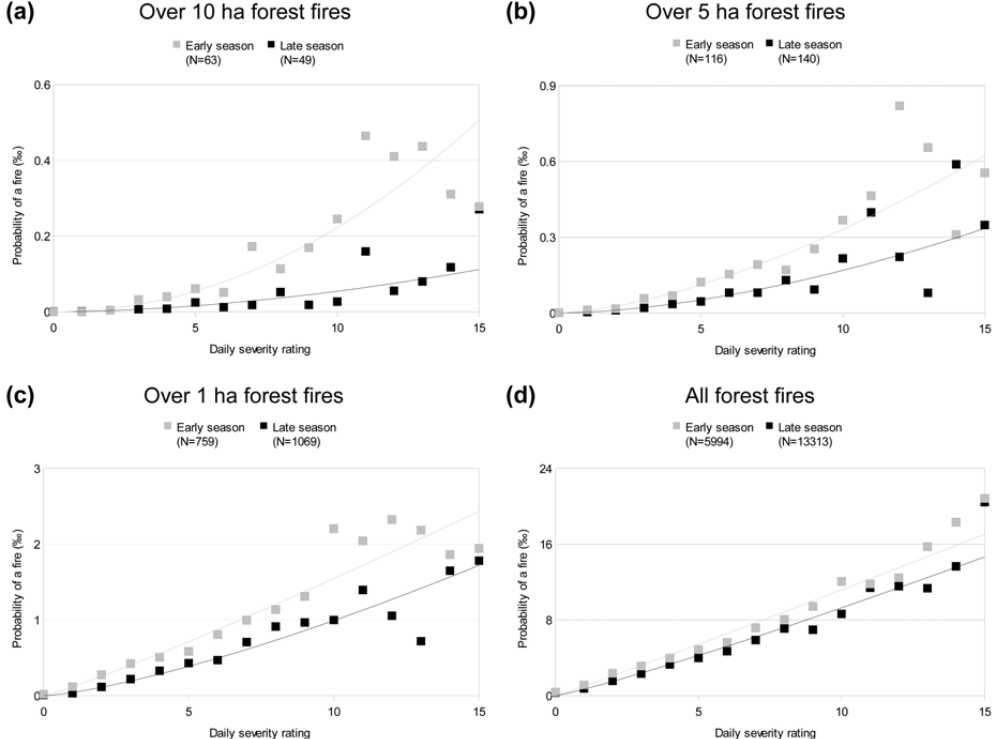
Figure 3. The relationship between daily severity rating (DSR) and occurrence of forest fires of different size in Finland during 1996–2014, performed separately for the early (effective temperature sum below 250 ◦ C days; grey squares) and late season (effective temperature sum above 250 ◦ C days; black squares). (a) Forest fires over 10 ha (i.e. large forest fires). (b) Forest fires over 5ha. (c) Forest fires over 1ha. (d) All forest fires. The numbers of fires in each class is shown as